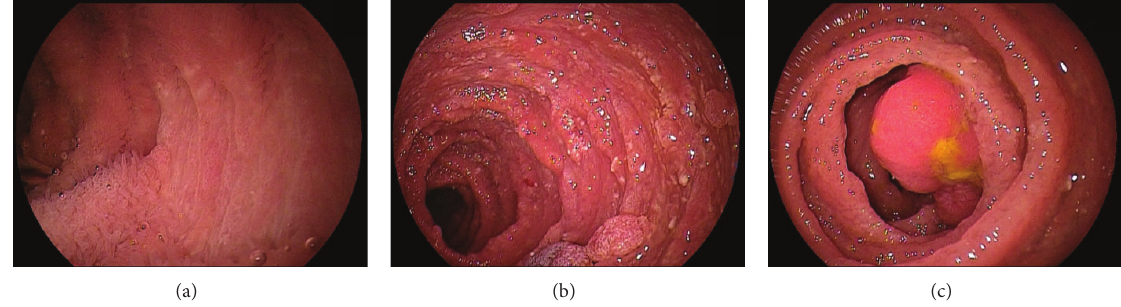
Figure 8: Jejunum. (a) Atrophic part of the jejunal mucosa without villi-denuded areas, (b) small hyperplastic/juvenile polyps of the jejunum, (c) large stalked polyp.